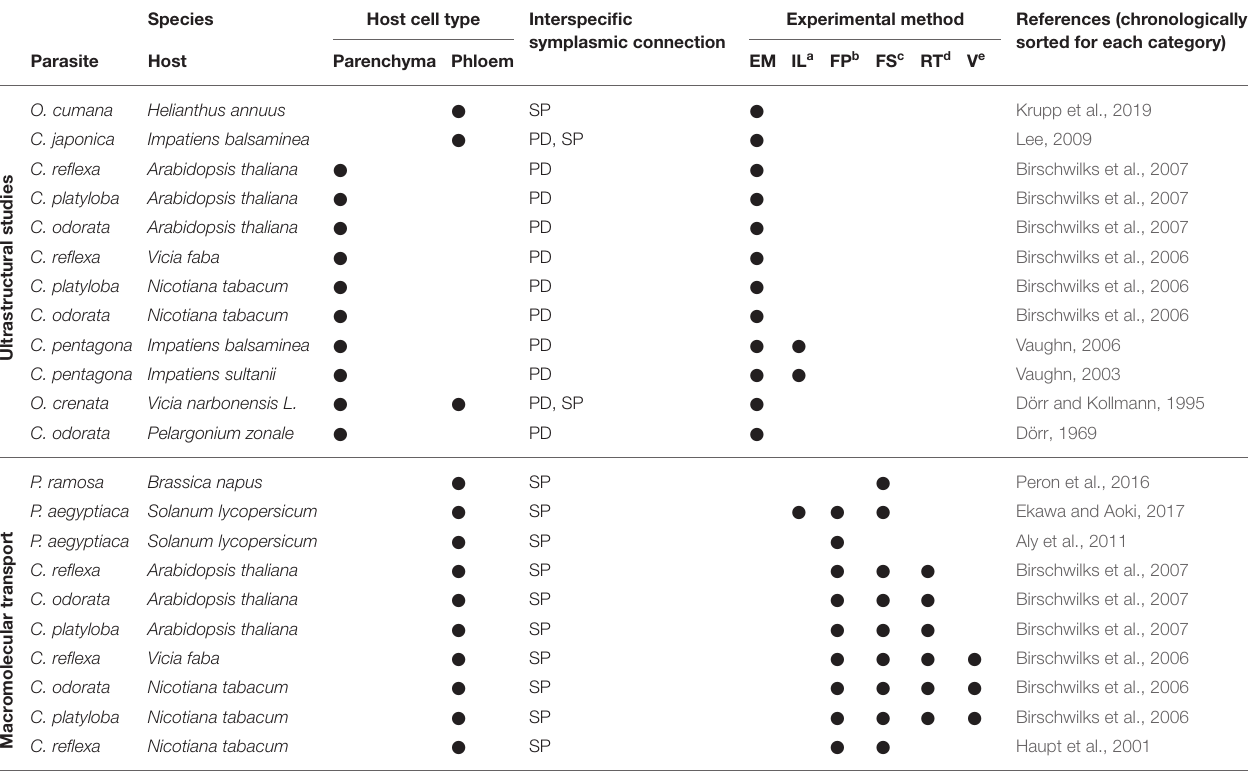
TABLE 1 | Summary of studies investigating cell-to-cell connections between parasitic plants and their hosts. Species Host cell type Interspecific Experimental symplasmic connection